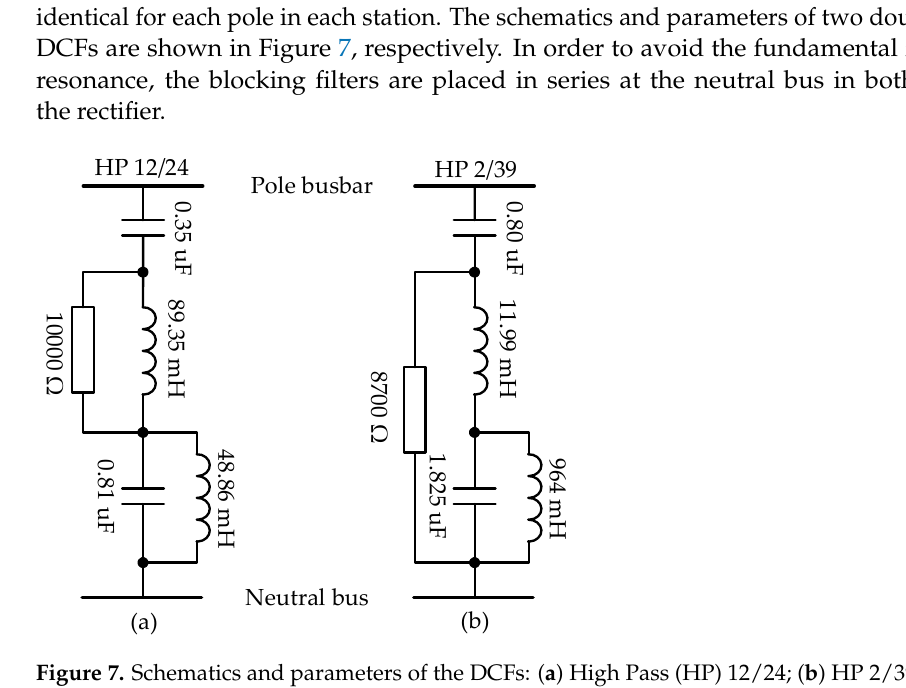
Table 3 elaborates the parameters of the overhead DC lines and the electrode lines.